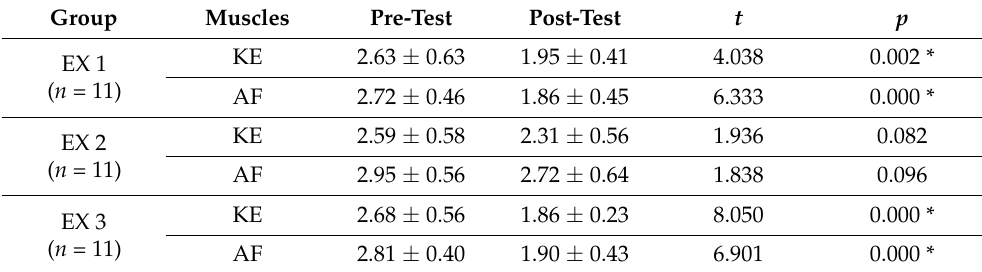
Table 2. Comparative analysis of changes in MAS. Group